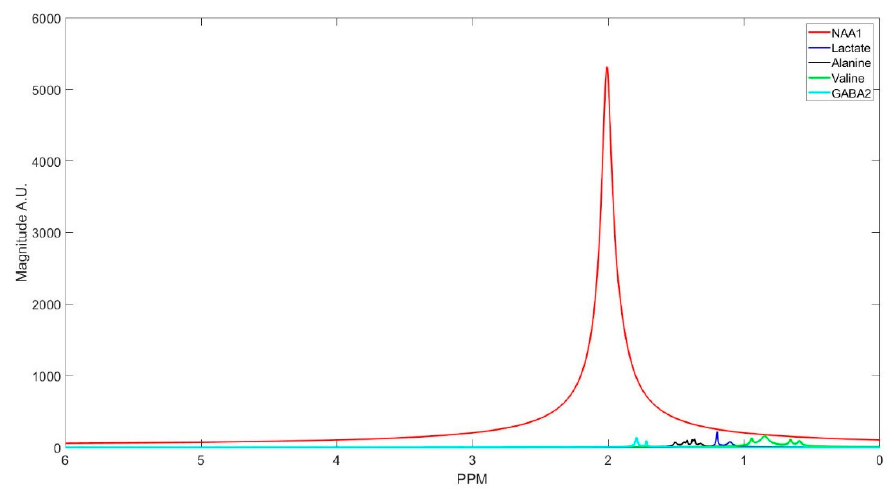
Figure 8. Clustered metabolites basis sets of group 1.